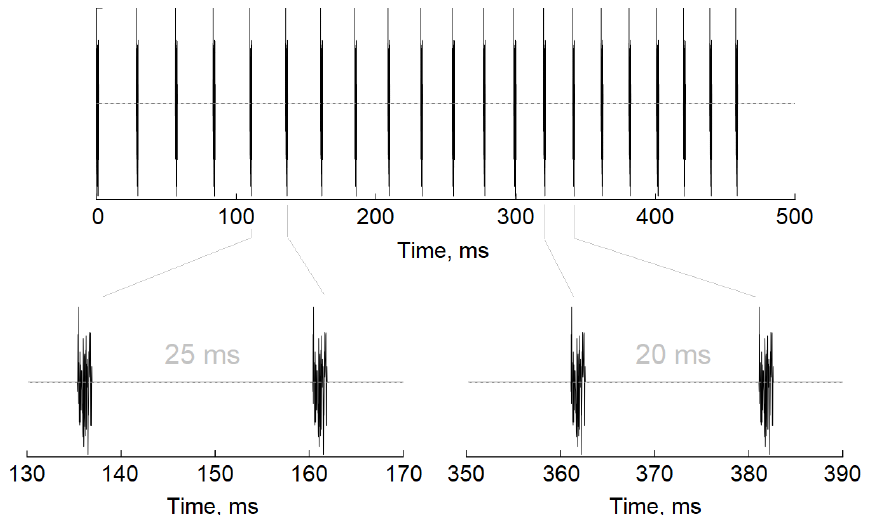
Figure 1. A schematic representation of chirp stimulus used in the study.